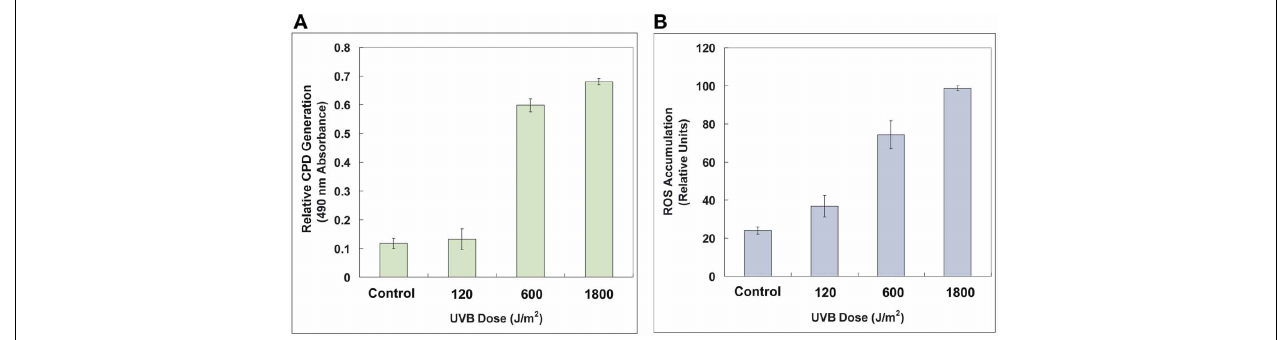
FIGURE 3 | Relative CPD generation (A) and ROS accumulation (B) of the control and the irradiated AMB-1 cells. The CPD formation was determined by 490nm absorbance. The ROS content was characterized by 525nm fluorescent intensity normalized protein content. See text for details.